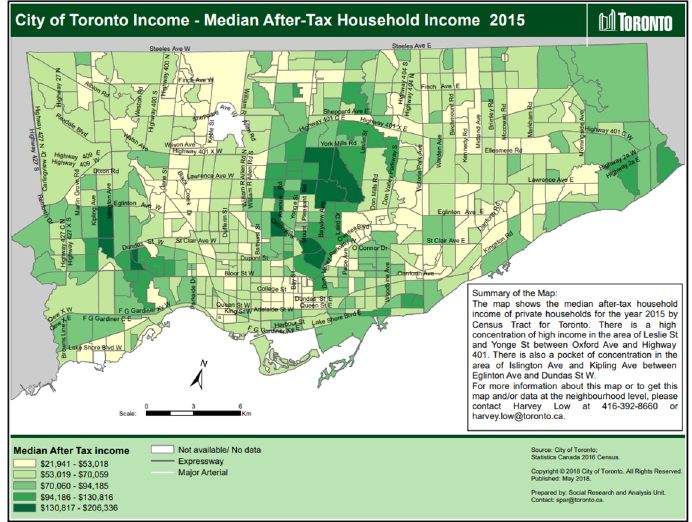
Figure 12 . Map of the City of Toronto showing median after-tax household income. (Source: City of Toronto, 2016) .